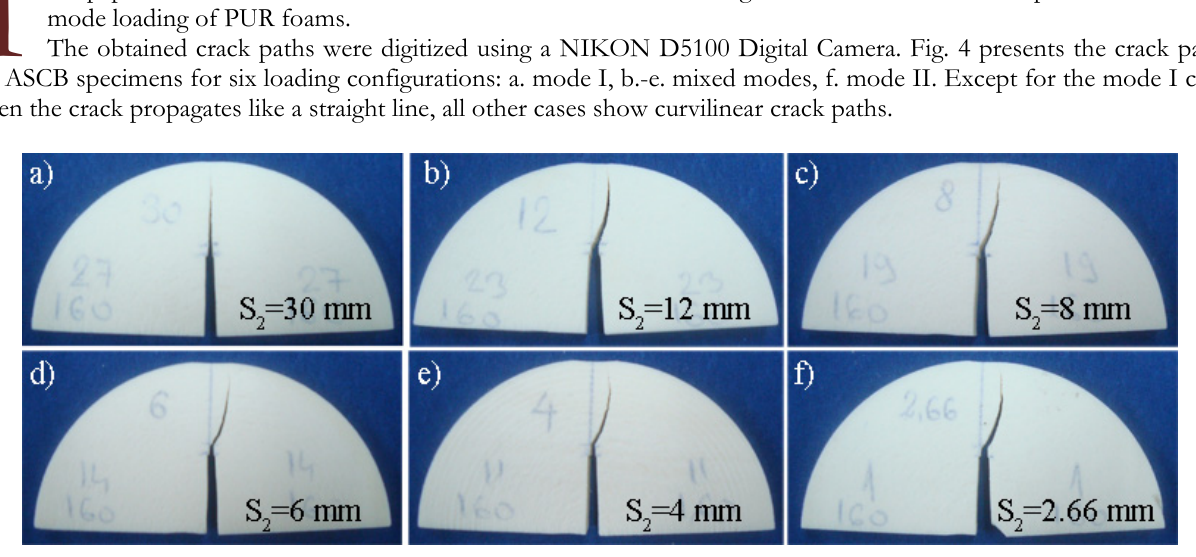
Figure 4 : Crack paths resulted from testing ASCB specimens.